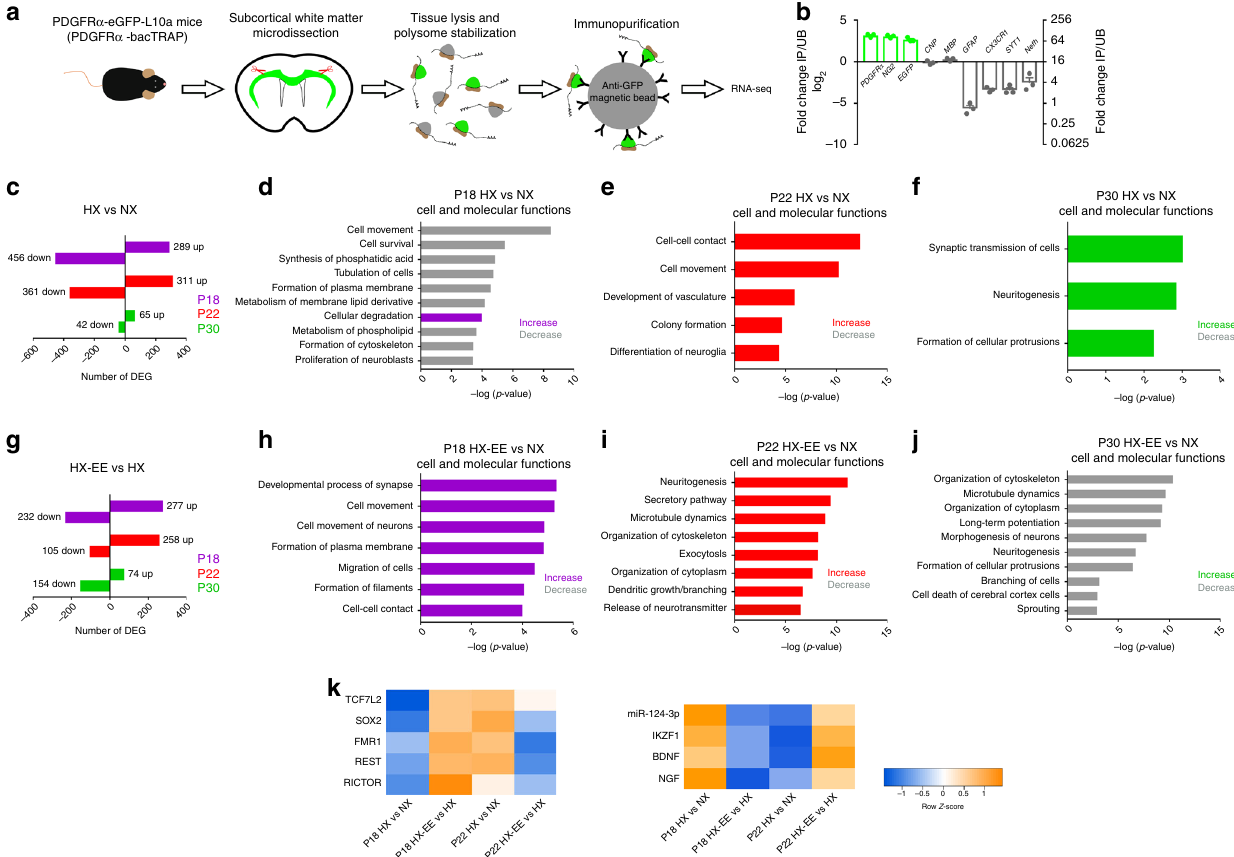
Fig. 8 RNA-seq reveals EE-induced changes in OPC translatome following perinatal hypoxia. a Schematic representation of experimental design and TRAP methodology. b qRT-PCR analysis of immunoprecipitated (IP) and unbound (UB) fractions from the white matter of PDGFR ɑ -bacTRAP mice. Green bars correspond to genes enriched in OPCs, and grayscale bars correspond to genes enriched in other cell types. Bars represent mean ± SEM ( n = 3 per group). Platelet-derived growth factor receptor alpha ( Pdgfr α ), neural/glial antigen 2 ( NG2 ), enhanced green fl uorescent protein ( Egfp ), Cnp , myelin basic protein ( Mbp ), glial fi brillary acidic protein ( Gfap ; astrocytes), fractalkine receptor ( Cx3cr1 ; microglia), synaptotagmin-1 ( Syt1 ; neurons), and neuro fi lament- heavy ( Nefh ; axons). c Number of DEGs between HX and NX mice at P18, P22, and P30 (Wald test with Benjamini − Hochberg post hoc, adjusted p < 0.05, normalized counts > 5) (P18: HX, n = 4, NX, n = 3; P22: HX, n = 5, NX, n = 6; P30: HX, n = 3, NX, n = 6). d – f Predicted increases (colored) and decreases (gray) in cell and molecular functions (determined by directional z -scores) in HX compared to NX at P18 ( d ), P22 ( e ), and P30 ( f ). Cell and molecular functions ranked based on p value as determined using Fisher ’ s Exact Test. g Number of DEGs between HX-EE and HX mice at P18, P22, and P30 (Wald test with Benjamini − Hochberg post hoc, adjusted p < 0.05, normalized counts > 5) (P18: n = 4 per group; P22: n = 5 per group; P30: HX-EE, n = 5, HX, n = 3). h – j Predicted increases (colored) and decreases (gray) in cell and molecular functions (determined by directional z -scores) in HX-EE compared to HX at P18 ( h ), P22 ( i ), and P30 ( j ). Cell and molecular functions ranked based on p value as determined using Fisher ’ s Exact Test. k Heatmaps of